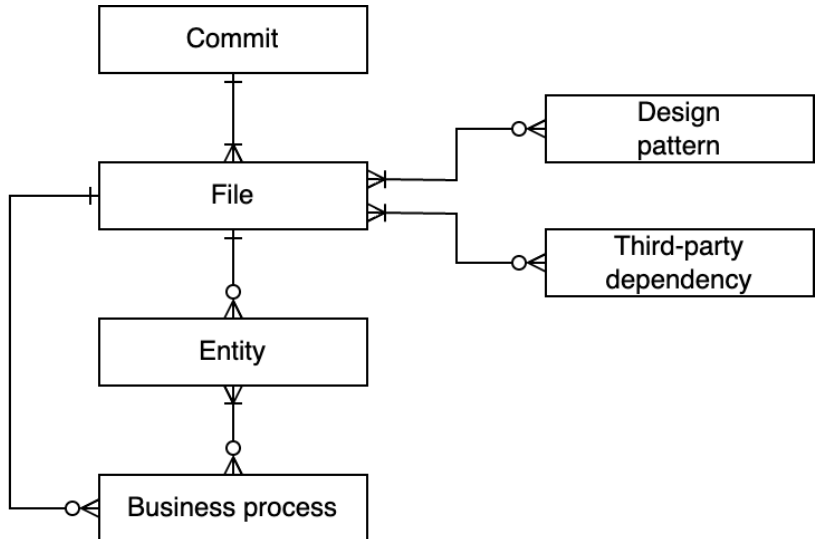
Figure 8. ER diagram for the ’Commit’